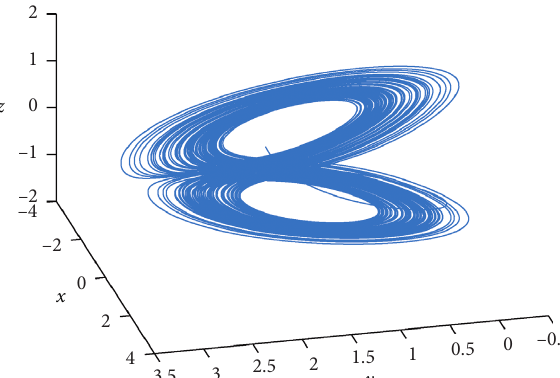
Figure 13: Dynamic behavior of fractional financial chaotic model with α � 0 . 95.